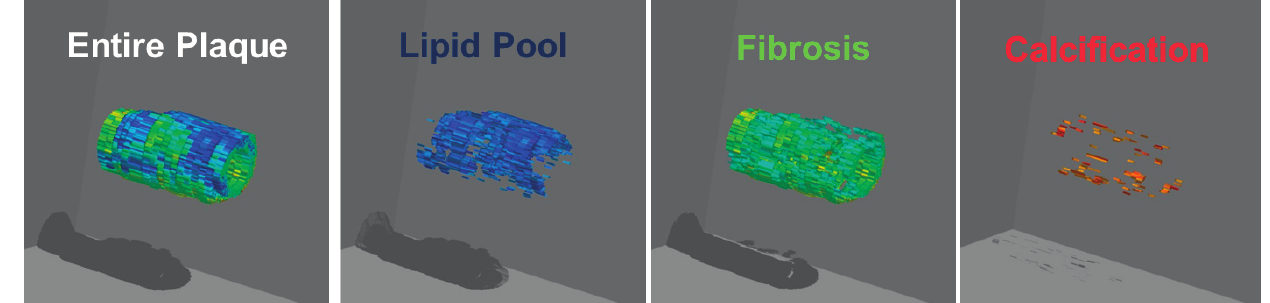
Figure 8. Three-dimensional color-coded maps of the coronary arterial plaques constructed by